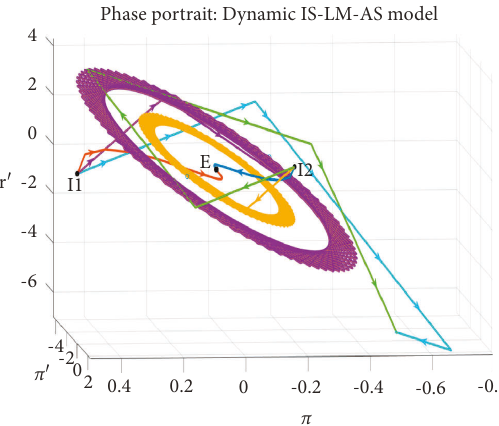
Figure 16: Three-dimensional phase portrait.